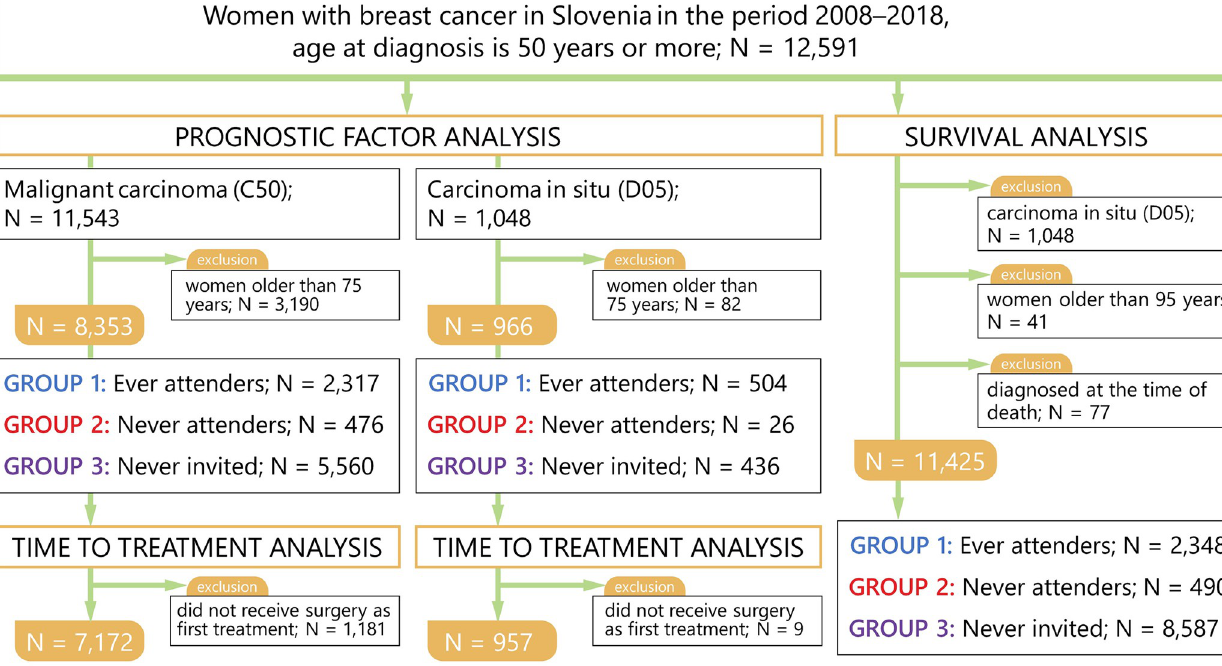
PLOS ONE | https://doi.org/10.1371/journal.pone.0278384 November30,